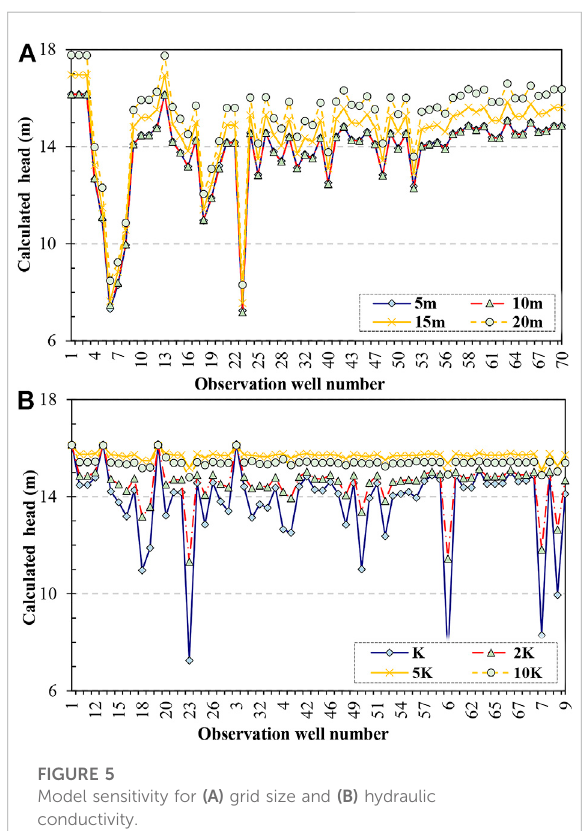
FIGURE 5 Model sensitivity for (A) grid size and (B) hydraulic